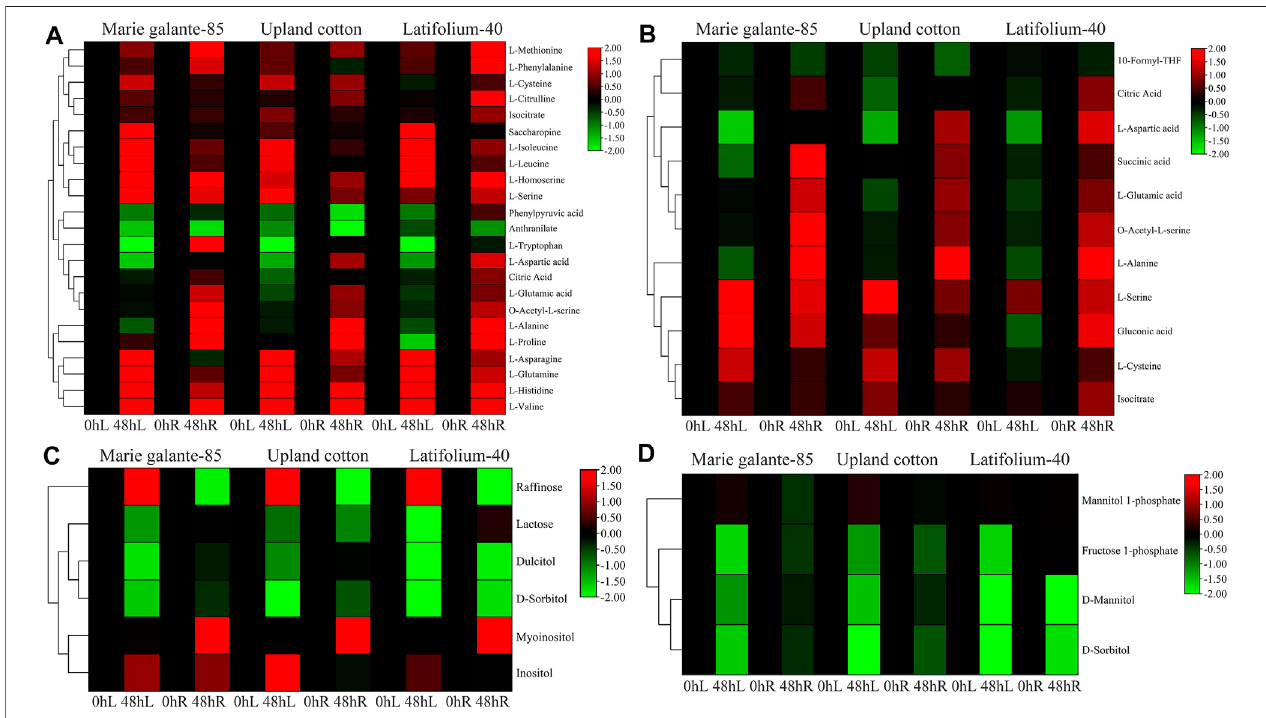
FIGURE 9 | Metabolite enrichment analyses of PFK genes during drought stress. (A) . Biosynthesis of amino acids; (B) . Carbon metabolism; (C) . Galactose metabolism; (D) . Fructose and mannose metabolism. Heatmap was visualized by TBtools using the log2 data normalization of the metabolite expression.